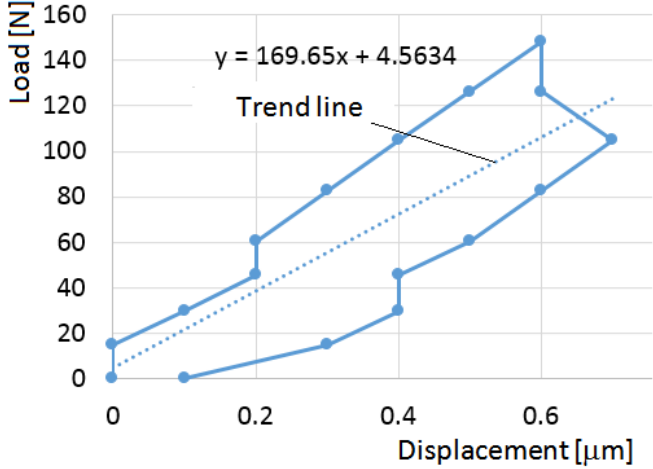
Figure 8. Stiffness measurement at position 8 (second round of load application). Trend line slope defines stiffness (169 N/ μ m).